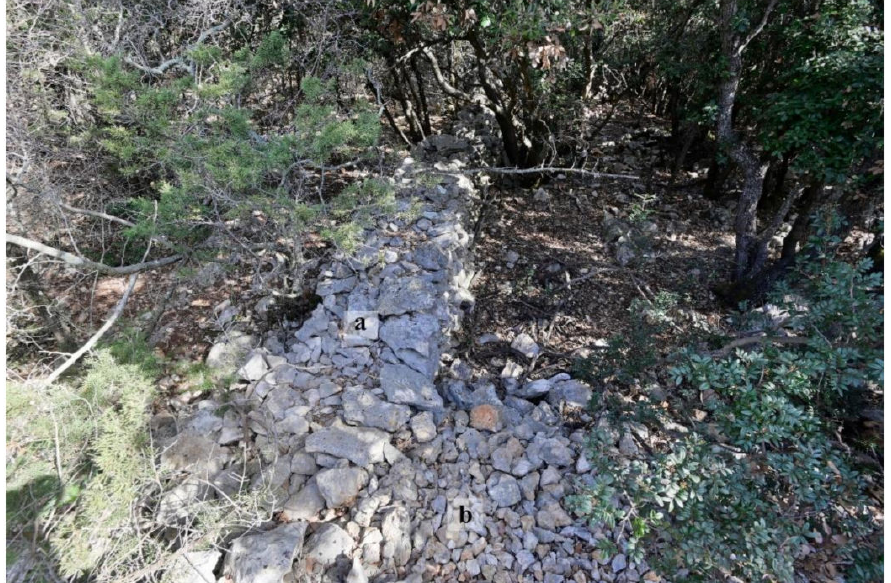
Figure 20. ( a ) Double dry stone wall against which ( b ) clearance stones are piled. The double wall extends to the north, while the clearance stones in the photograph are the northern end of a massive stone deposit continuing to the south. The position of this photograph is marked by the white arrow in Figure 19. (Photo: M. Doneus, 13 April 2022).